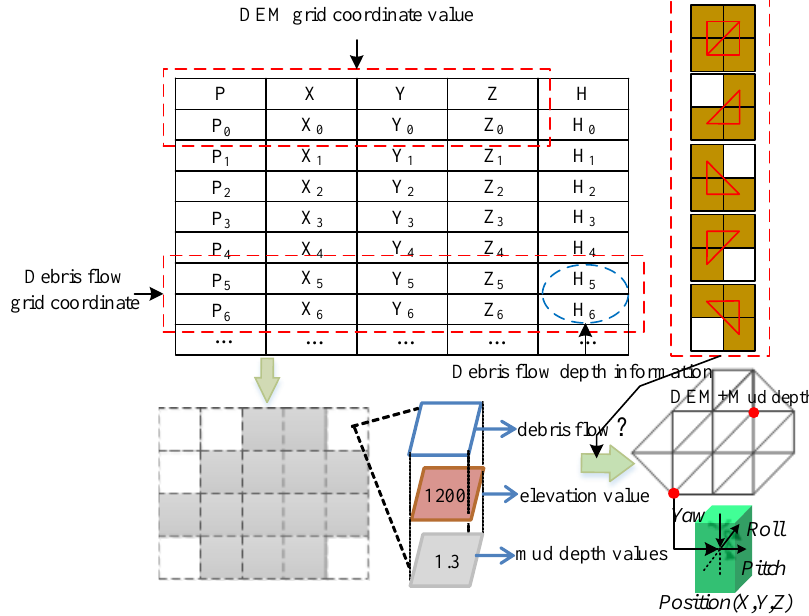
Figure 9. Construction of debris flow scenes with spatial location constraints.